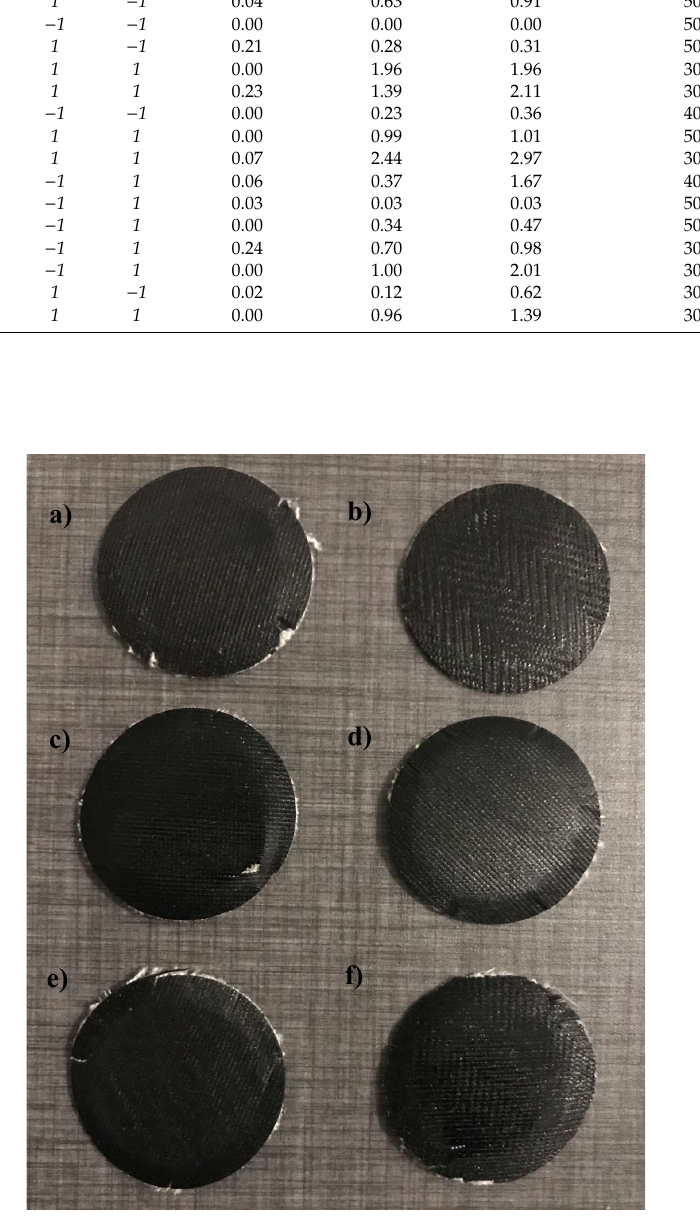
Figure A1. 3 D-PPOT samples after abrasion experiment using ( a,c,e ) 14, 18 and 22 picks/inch plain Figure A1. 3D-PPOT samples after abrasion experiment using ( a , c , e ) 14, 18 and 22 picks / inch plain fabrics, respectively, and ( b,d,f ) 14, 18 and 22 picks/inch twill fabrics, respectively. fabrics, respectively, and ( b , d , f ) 14, 18 and 22 picks / inch twill fabrics,